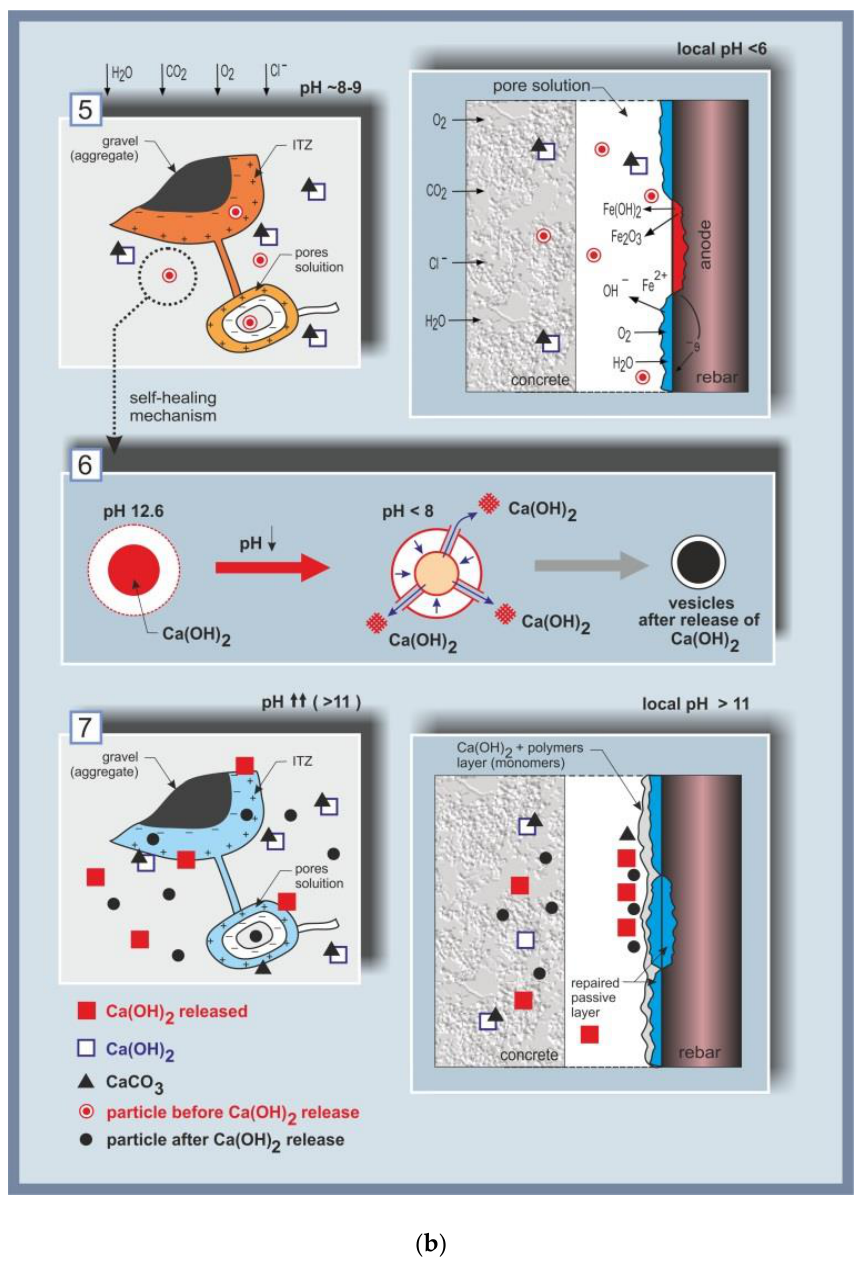
Figure 1. ( a ) The reinforced concrete system, (1), with relevant zones of interest, (2) and (3), i.e., the cementitious bulk matrix, the steel/cement-paste interface, and admixed nanoparticle distribution, (3), together with the relevant types of nanoparticles,(4); left— the system prior to changes from external factors, sections (1) to (4); ( b ) The reinforced concrete system after degradation, (5), followed by self-healing, (7), due to the effect of nanoparticles, (6).